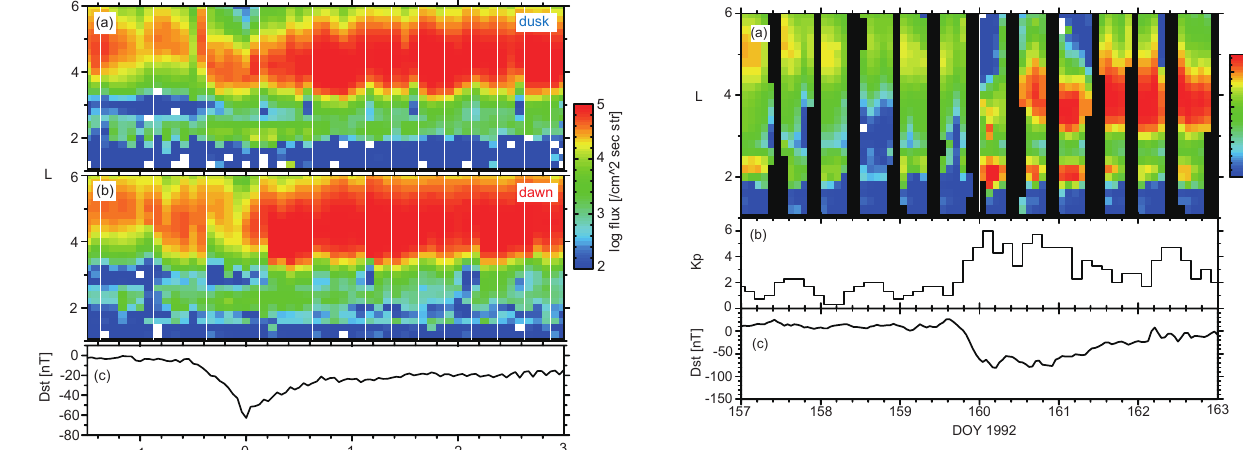
Fig. 4. Superposed electron flux (300–1100keV), and D st index for 32 storms. The zero epoch is taken to be the time of the minimum D st value. (a) 2-h-averaged electron flux at the dusk side. (b) 2- h-averaged electron flux at the dawn side. (c) the superposed D st index.